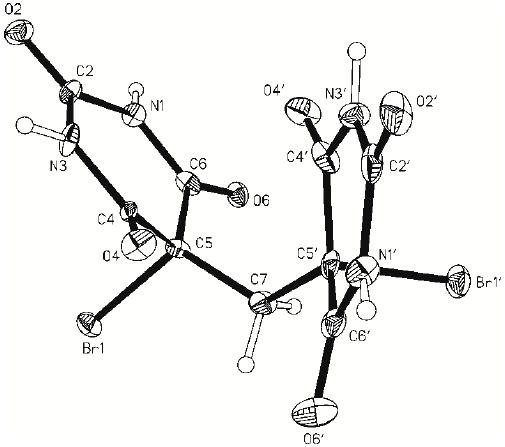
Figure 4. Molecular structure of 2 . Thermal ellipsoids are drawn at the 70% probability level and H-atoms drawn as spheres of arbitrary size.